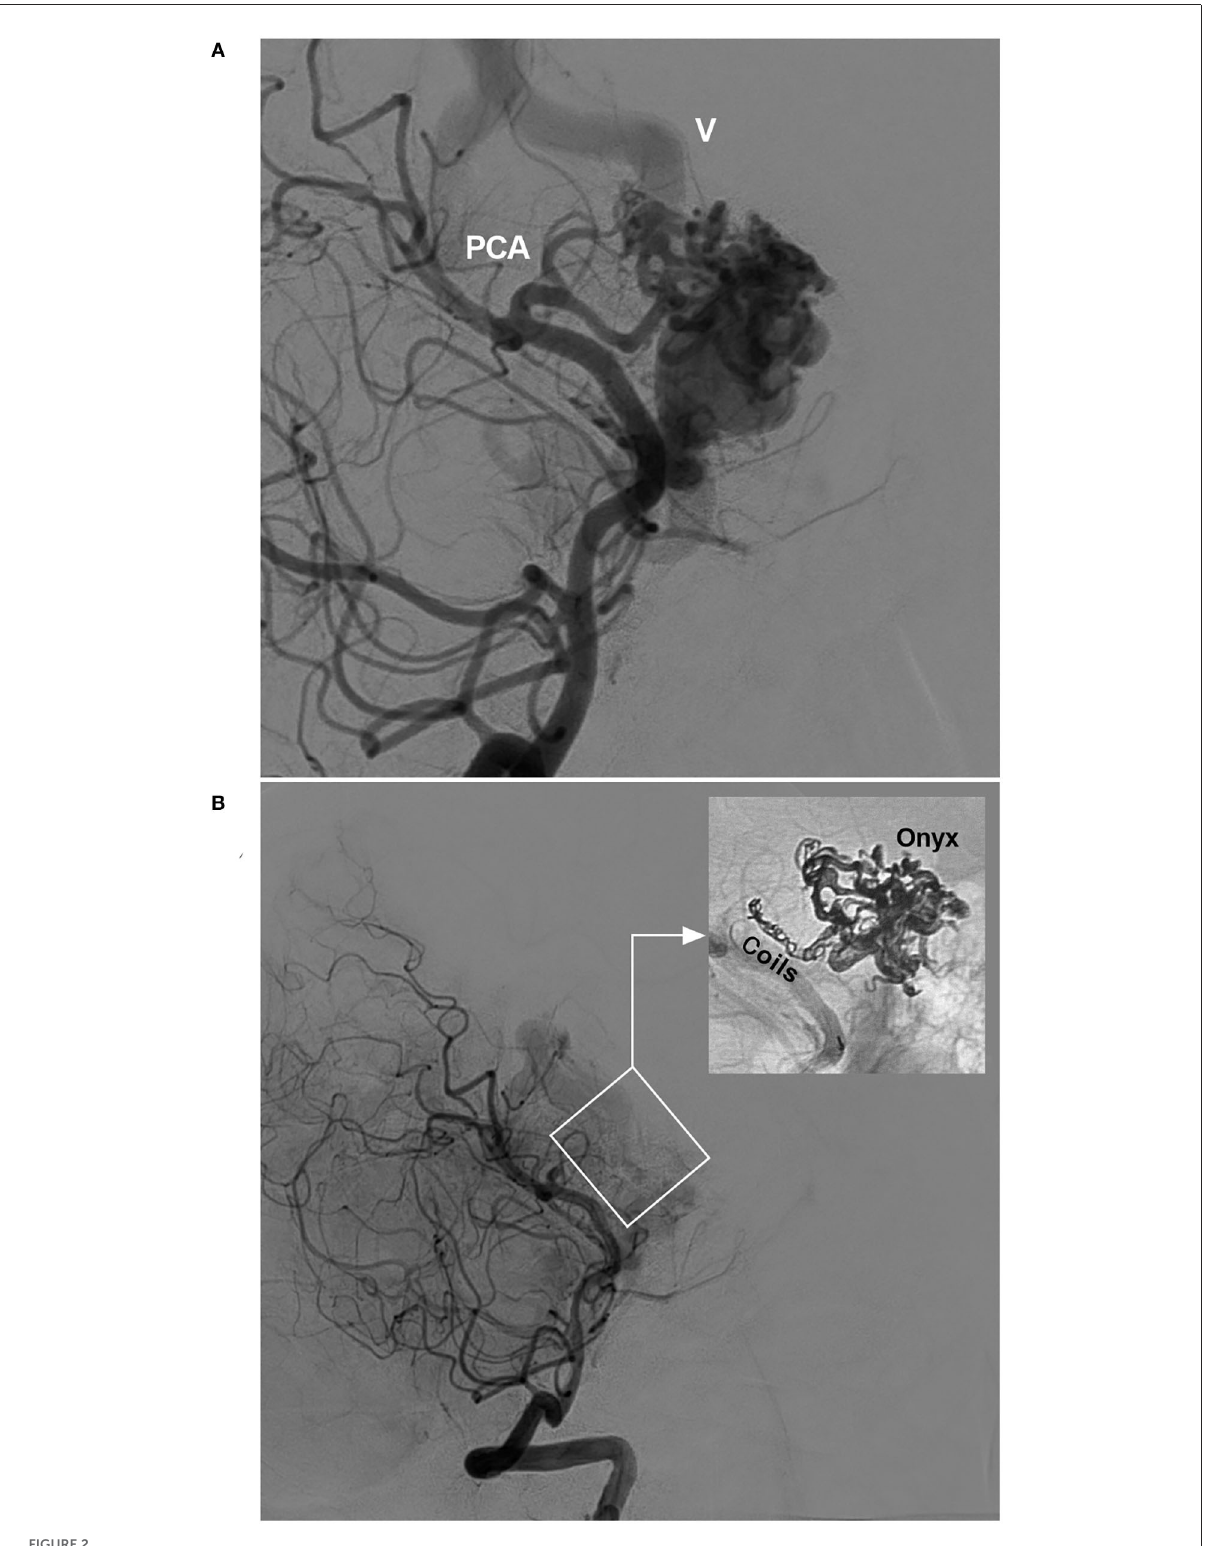
FIGURE2 Pressure cooker technique (case 22). (A) Angiogram of the VA showing the BAVM supplied by the PCA. Deep vein drainage (V) was indicated. (B) Post-operative angiogram of the VA showing nearly complete embolization of the BAVM (frame); demonstration of the pressure cooker technique (inset). Coils were deployed in the feeding artery to prevent Onyx reflux. BAVM, brain arteriovenous malformation; PCA, posterior cerebral artery; VA, vertebral